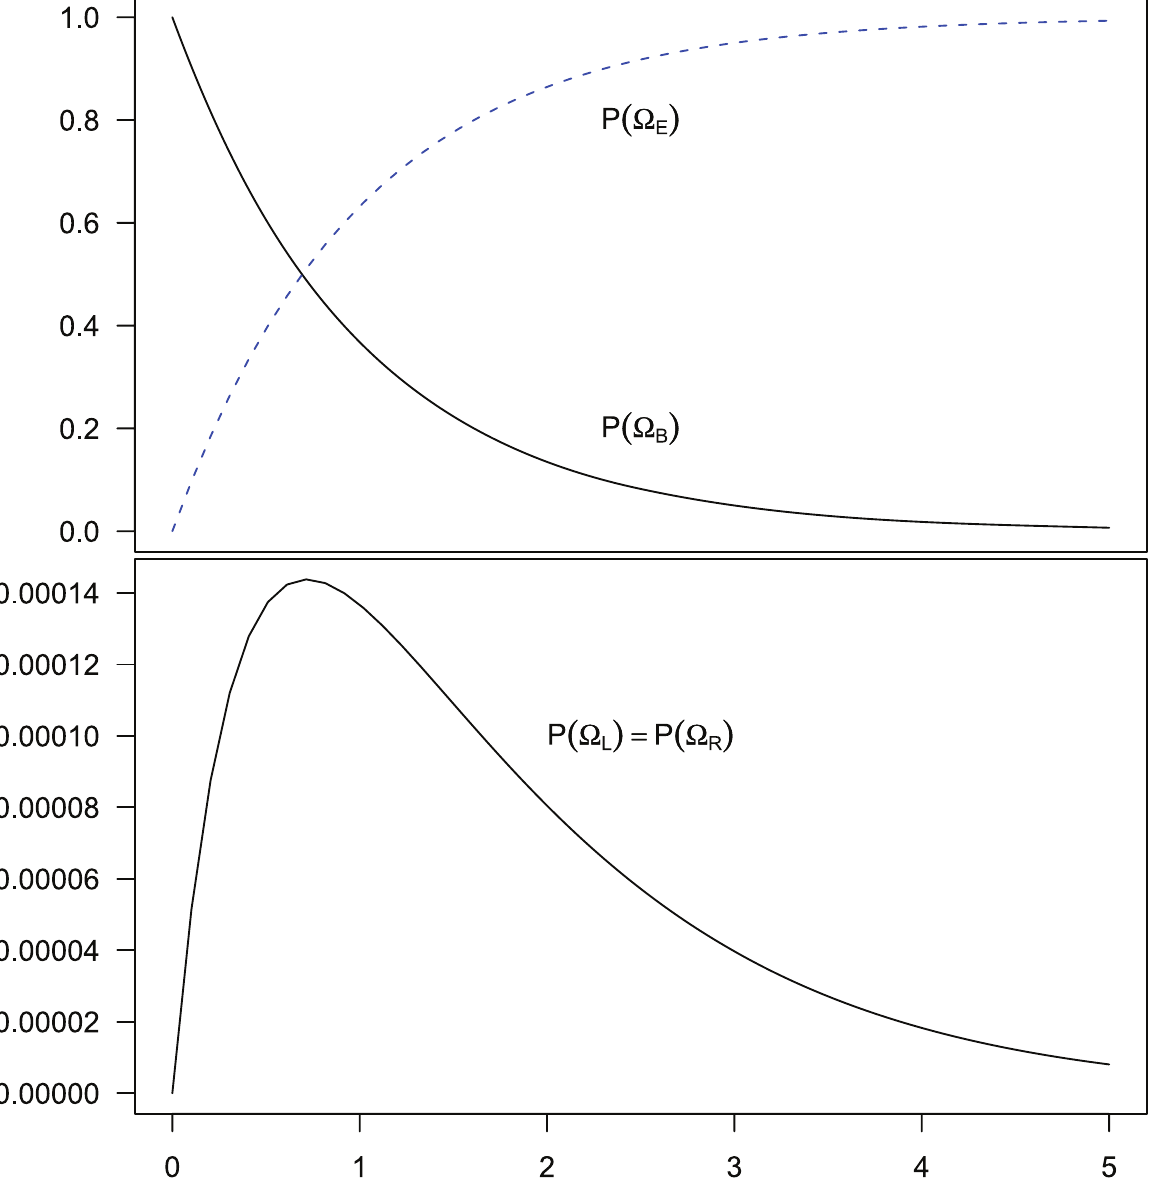
Figure 6. Evolution of the two-sequence CTMC. The figure shows how the probability of being in one of the four classes of states evolve over time. Initially, the system is in V B with probability 1, but this probability drops exponentially. With a relatively small probability the system will go through a state in V L or V R before ending up in V E but mainly V B states move directly to V E states. The rate parameters used are the same as those in Figure